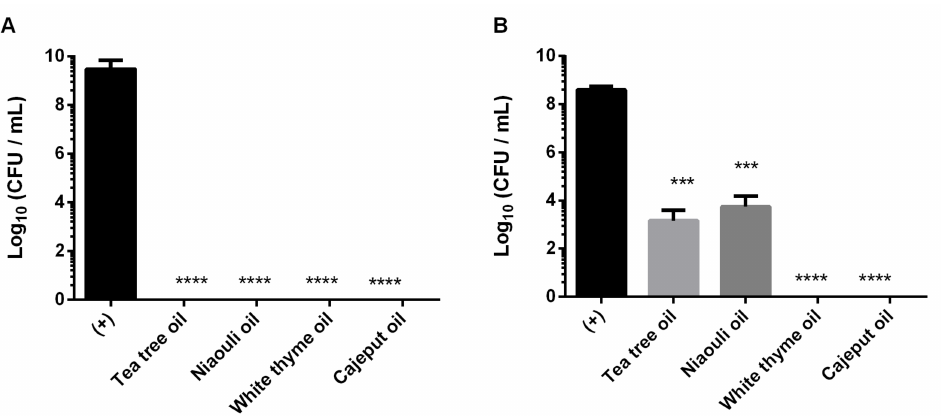
Figure 2. Antifungal effect of four essential oils (tea tree, niaouli, white thyme and cajeput) in biofilm formation ( A ) and 24 h old biofilms ( B ) of C. auris . *** p < 0.001, **** p < 0.0001 indicates a statistically different reduction in comparison with the control